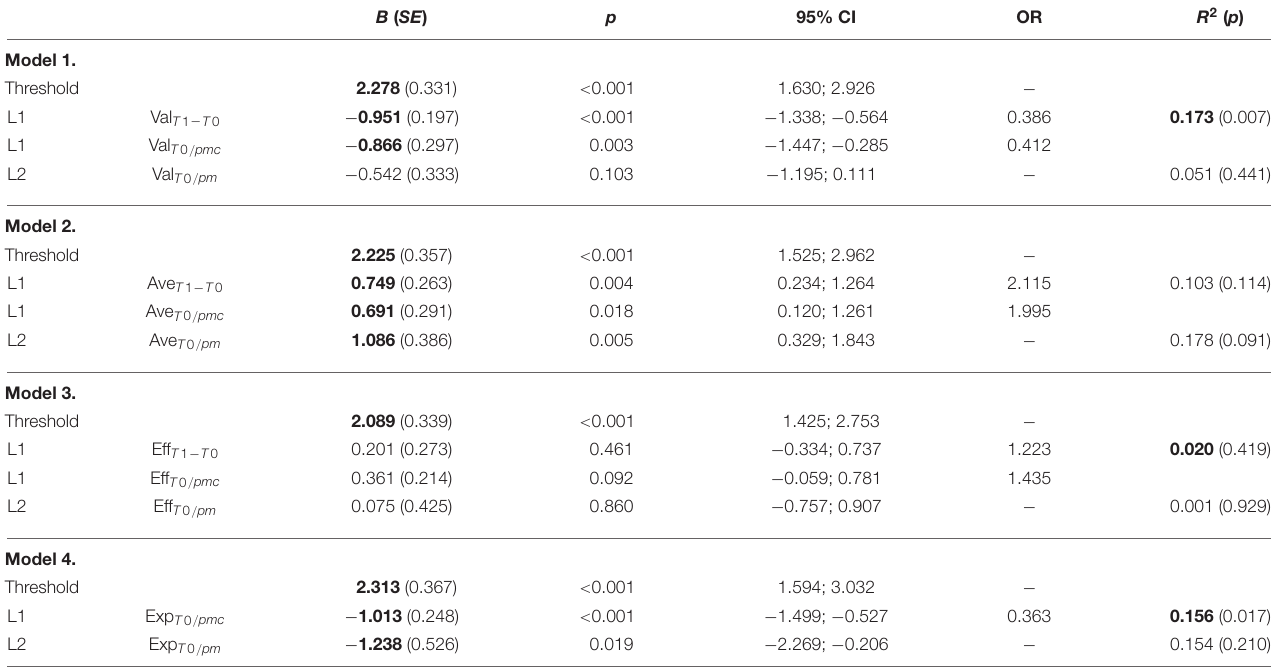
TABLE 3 | Distinct multi-level-models predicting the risk to delay ( Y = 1) vs. work on a task ( Y = 0), based on initial task-specific assessments (T0) and change indicators (T1–T0). B ( SE ) p 95% CI OR R 2 ( p ) Model